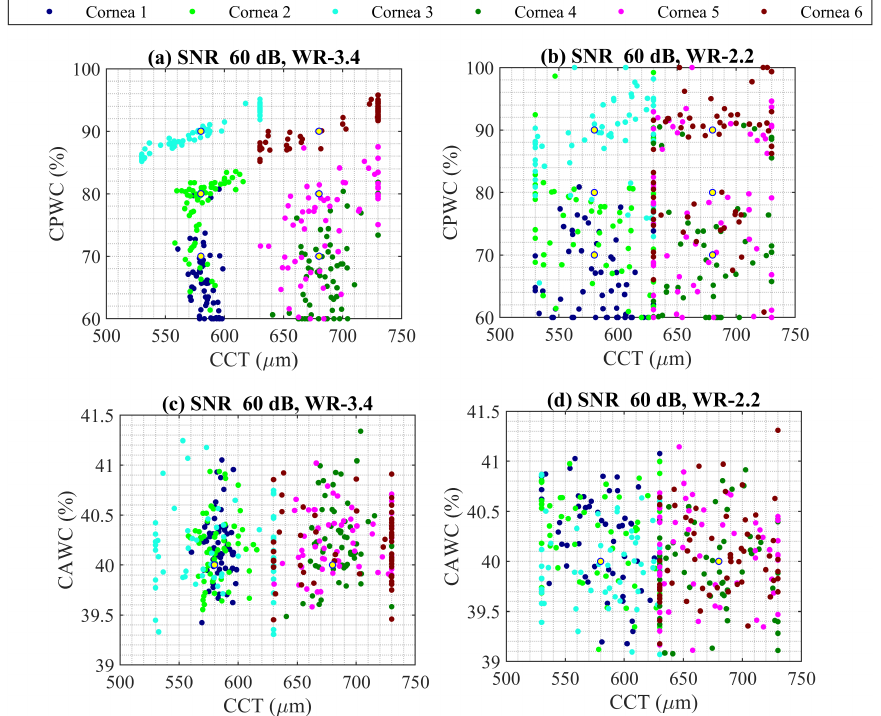
Figure 6. PSO analysis comparison for ( a , c ) WR-3.4 (220–330 GHz), and ( b , d ) WR-2.2 (330–500 GHz), considering SNR 60 dB for six correctly calibrated noisy corneas. Nominal values are shown with yellow dot and each cornea properties is plotted with different